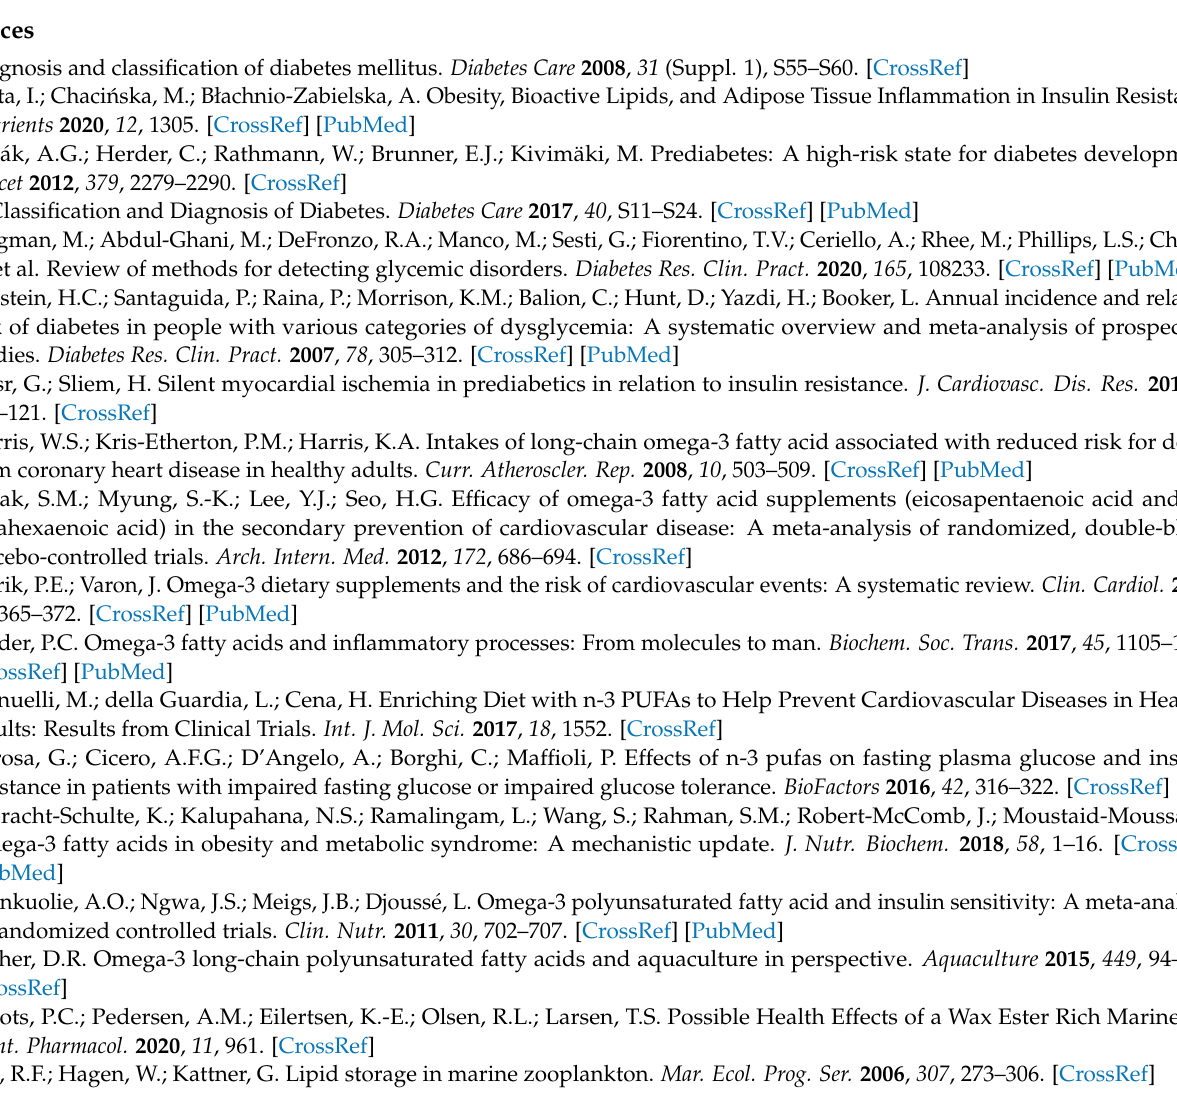
Values are given as mean ± SD. CHO, Carbohydrates; SFA, saturated fatty acids; MUFA, monounsaturated fatty acids; PUFA, polyunsaturated fatty acids; DHA, docosahexaenoic acid; EPA, eicosapentaenoic acid. p a -values represent the time * intervention interaction analysed with a two-way repeated measure ANOVA. p b -values represented the time effect within the groups. * p < 0.05 after post hoc Bonferroni correction from t 0 to t 12 and t 0 to t 16 , respectively; no significant differences were observed from t 12 to t 16